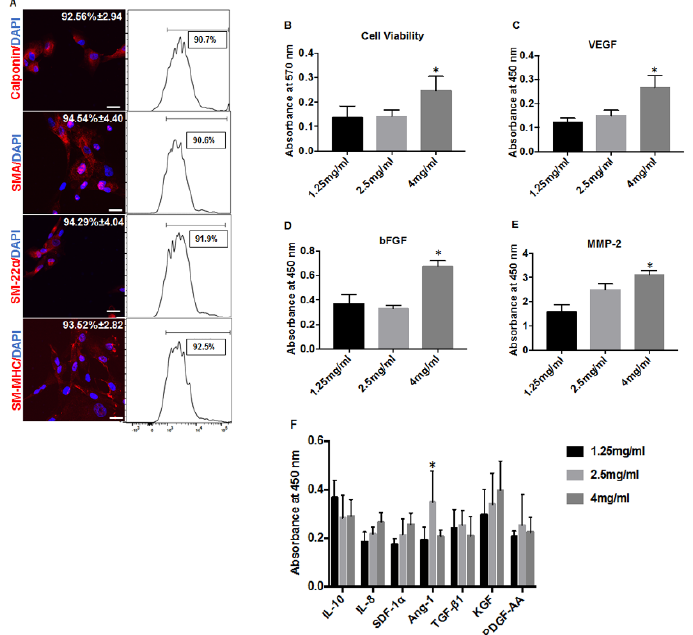
Figure 1. Collagen-density-dependent paracrine factor secretion of hiPSC-VSMCs in hydrated collagen scaffolds. Pure population of hiPSC-VSMCs was differentiated and characterized before embedding in the scaffolds. ( A ) Immunofluorescence images ( n = 3) and histograms of flow cytometry analysis with markers of hiPSC-VSMCs (i) calponin, (ii) smooth muscle alpha-actin (SMA), (iii) SM-22α and (iv) smooth muscle myosin heavy chain (SM-MHC). Dapi was used to stain nuclei. Scale bar measures 50 µm. ( B ) alamarBlue assay for cell viability of hiPSC-VSMC embedded in various